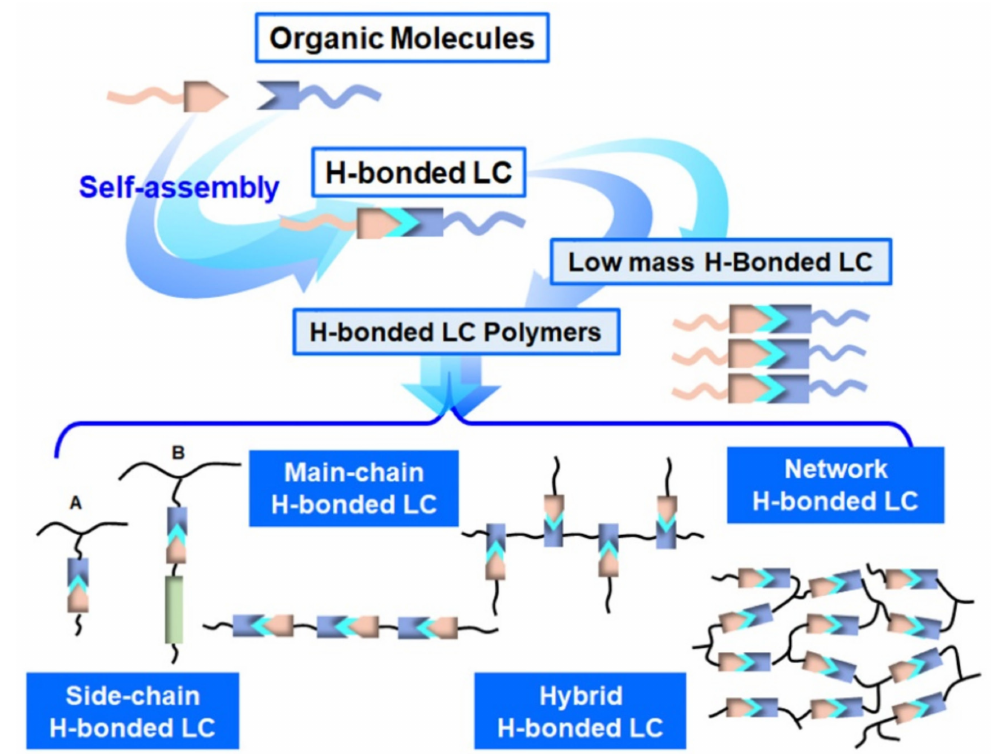
Figure 2. Classification of H-bonded supramolecular